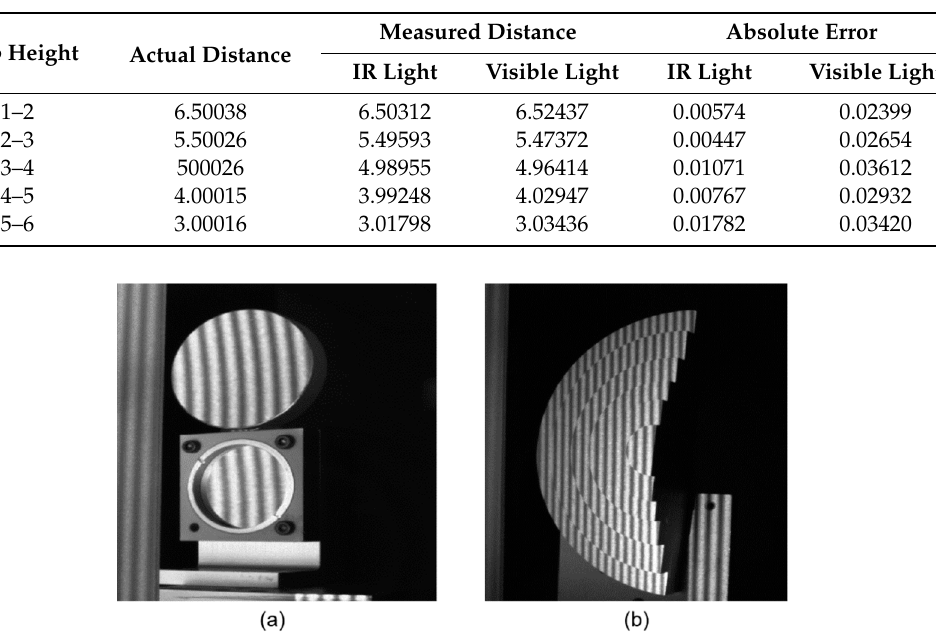
Figure 11. Wrapped phase maps of the measured specular objects. ( a ) Two separate specular objects; ( b ) Discontinuous fan-shaped mirror step. Figure 12. Unwrapped phase maps of the measured specular objects. ( a ) Two separate specular objects; ( b ) Discontinuous fan-shaped mirror step. By using the calibrated parameters, the 3D shape data of the measured specular objects were obtained, as illustrated in Figure 13a,b. The results demonstrate that the proposed method can directly measure specular objects having isolated and/or discontinuous surfaces.